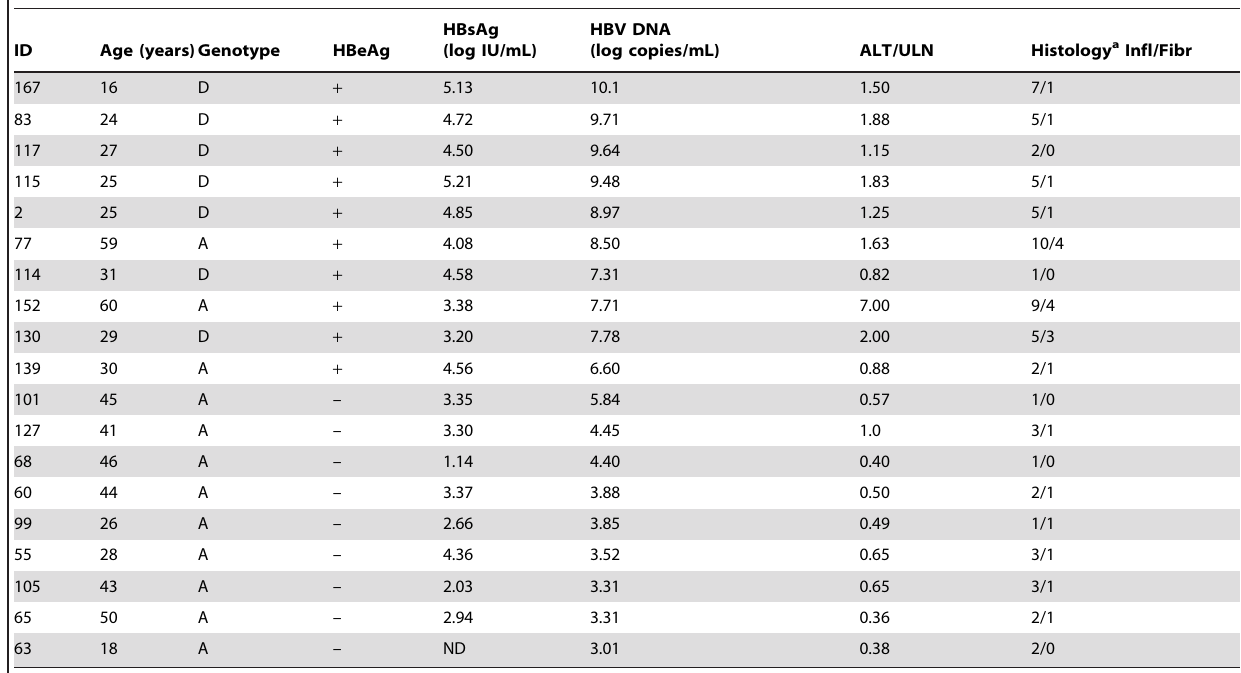
Table 1. Characteristics of 19 patients whose liver biopsies were analysed.